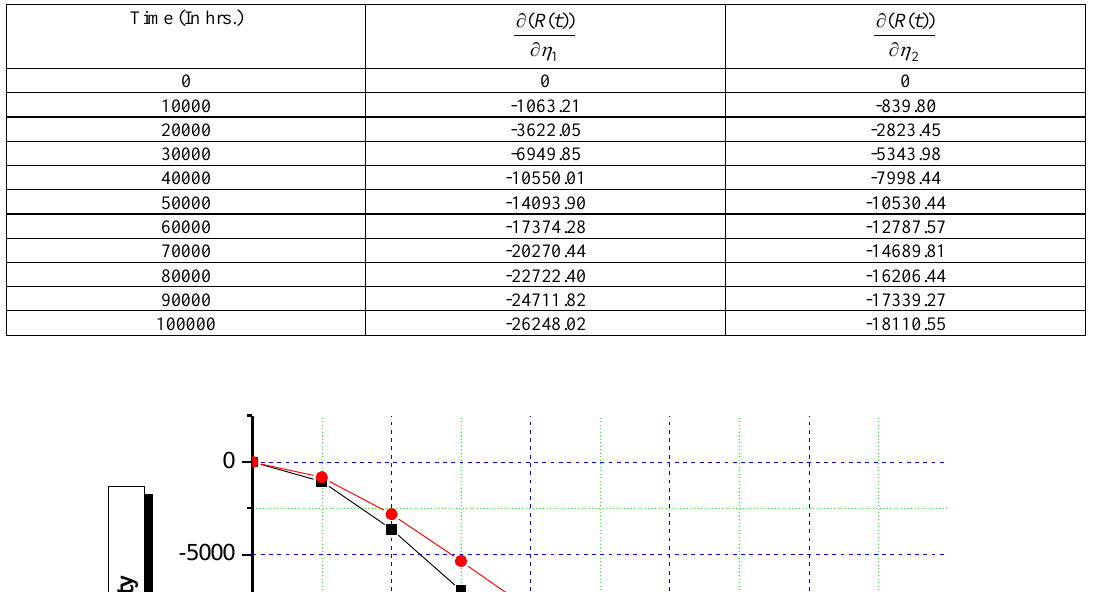
Table 6. Sensitivity of reliability.